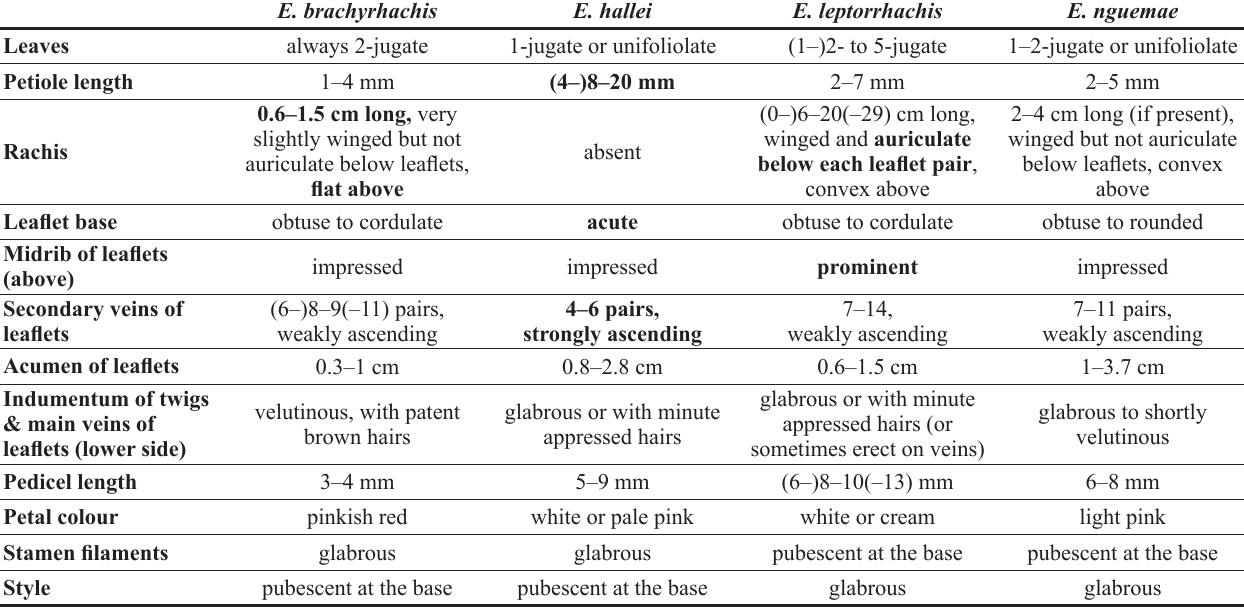
Table 1 – Differences between Englerodendron brachyrhachis , E. hallei , E. leptorrhachis , and E. nguemae . Diagnostic characters are in